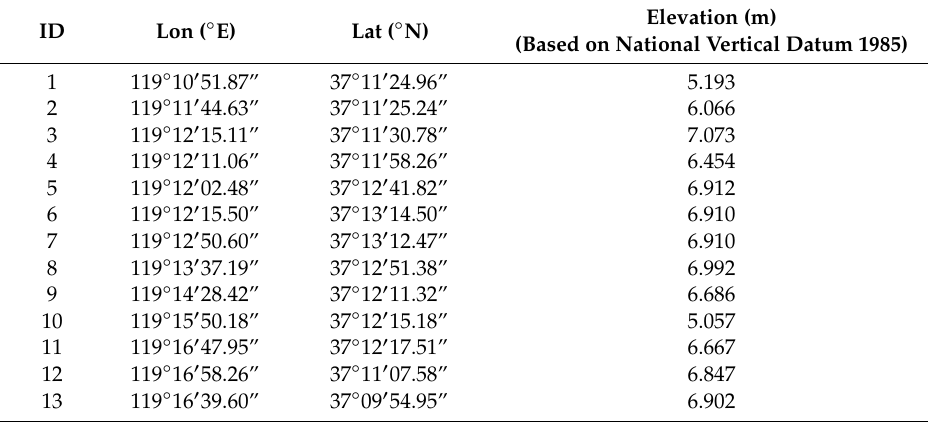
Table 1. Location and elevation of each of the 13 measuring points on the Weifang levee.